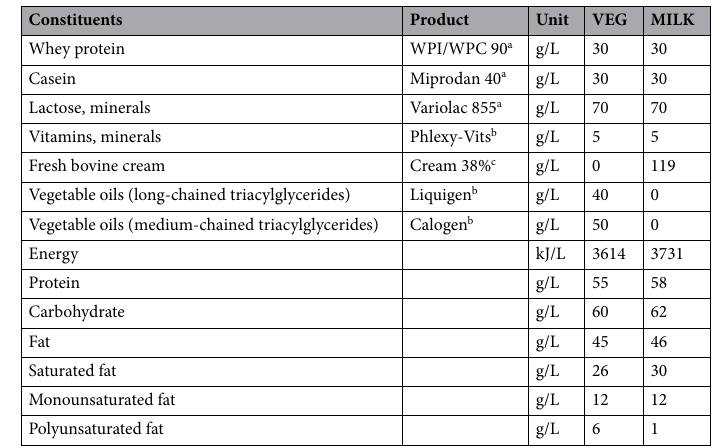
Table 1. Composition of the vegetable oil (VEG) and bovine milk fat (MILK) based diets. a Arla Food Ingredients, Viby J, Denmark. b Nutricia, Amsterdam, The Netherlands. c Arla Foods amba, Viby J,